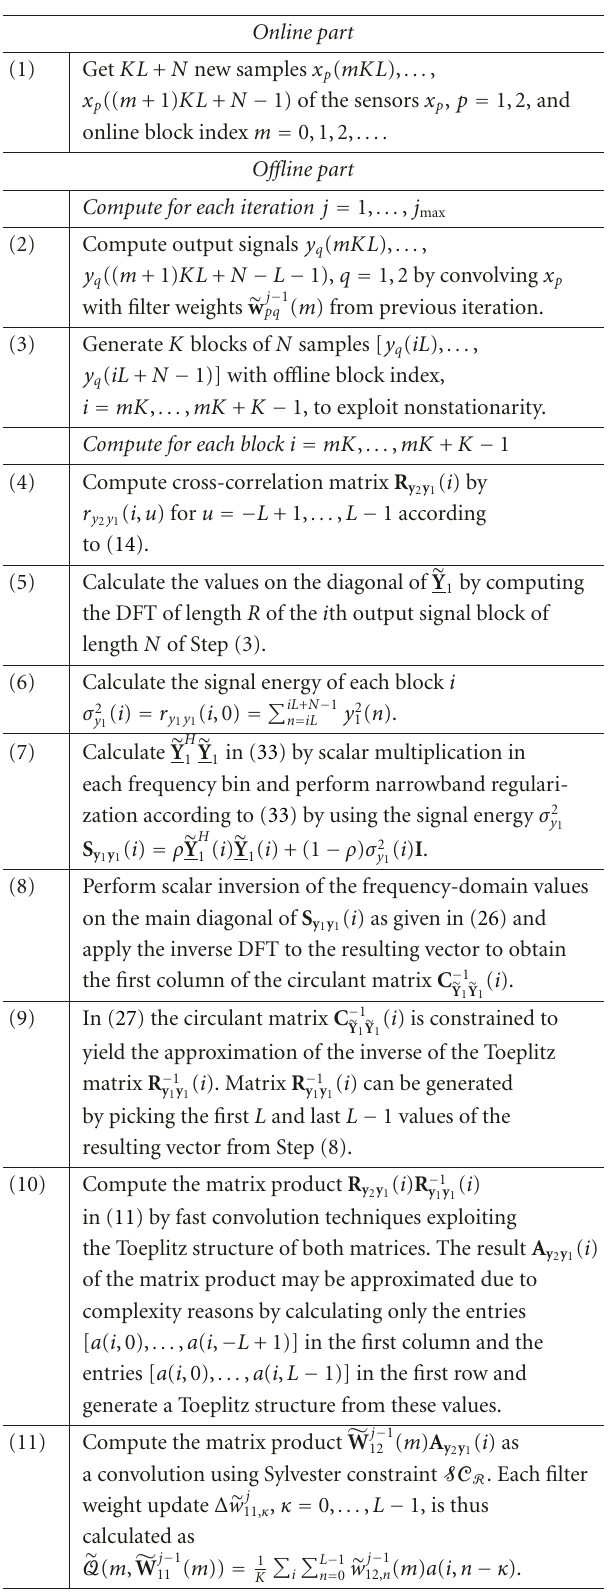
Table 1: Pseudocode of the block-online algorithm with improved normalization according to Section 3.3 exemplarily shown for the update Δ w 11 ( m ) in the 2 × 2 case. Online